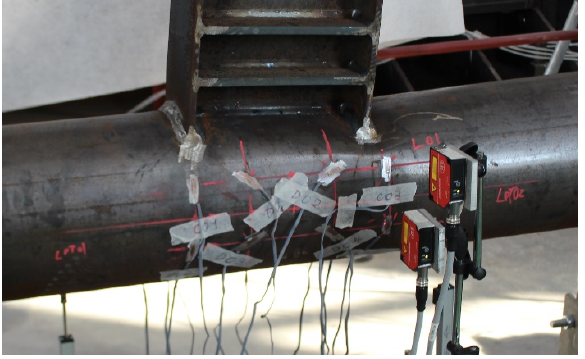
Figure 5. Arrangement of strain-gauges and transducers.